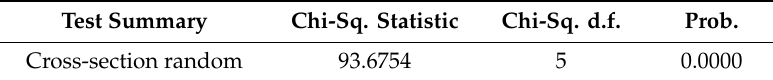
Table 6. Hausman test of panel data.